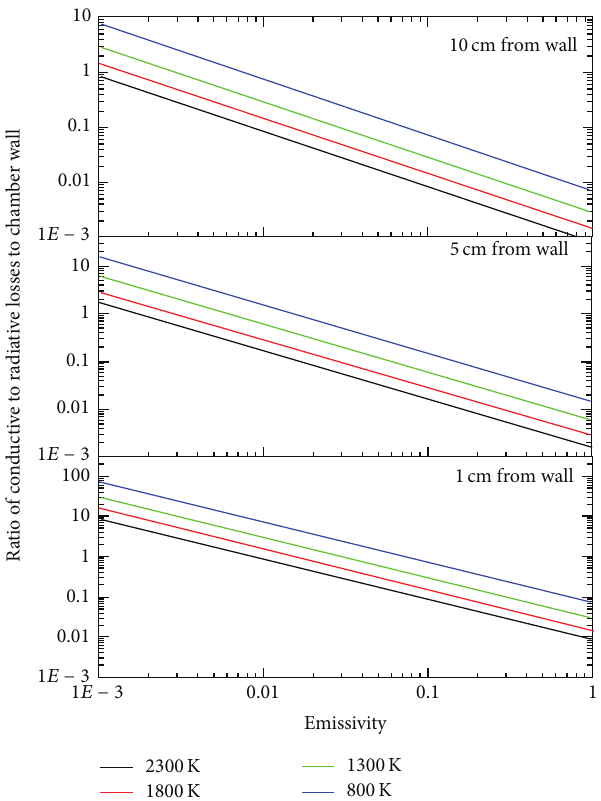
Figure 8: Calculated (first-order approximation) ratio of the con- ductive and radiative heat losses at multiple positions, at flame temperatures, and for 𝐹 = 1